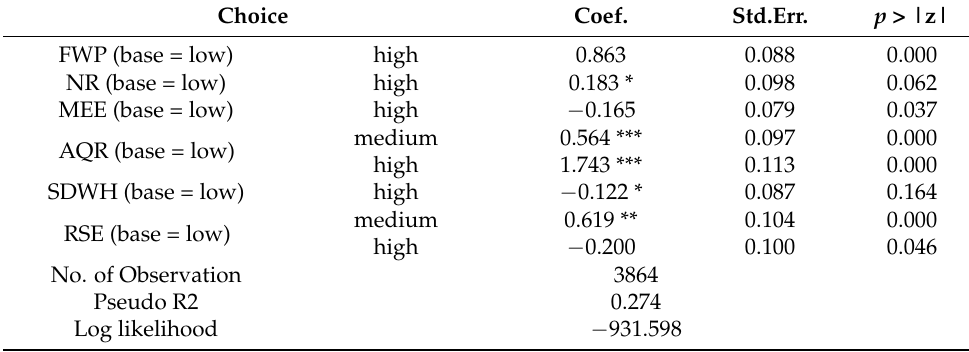
Table 11. Estimated conditional logit